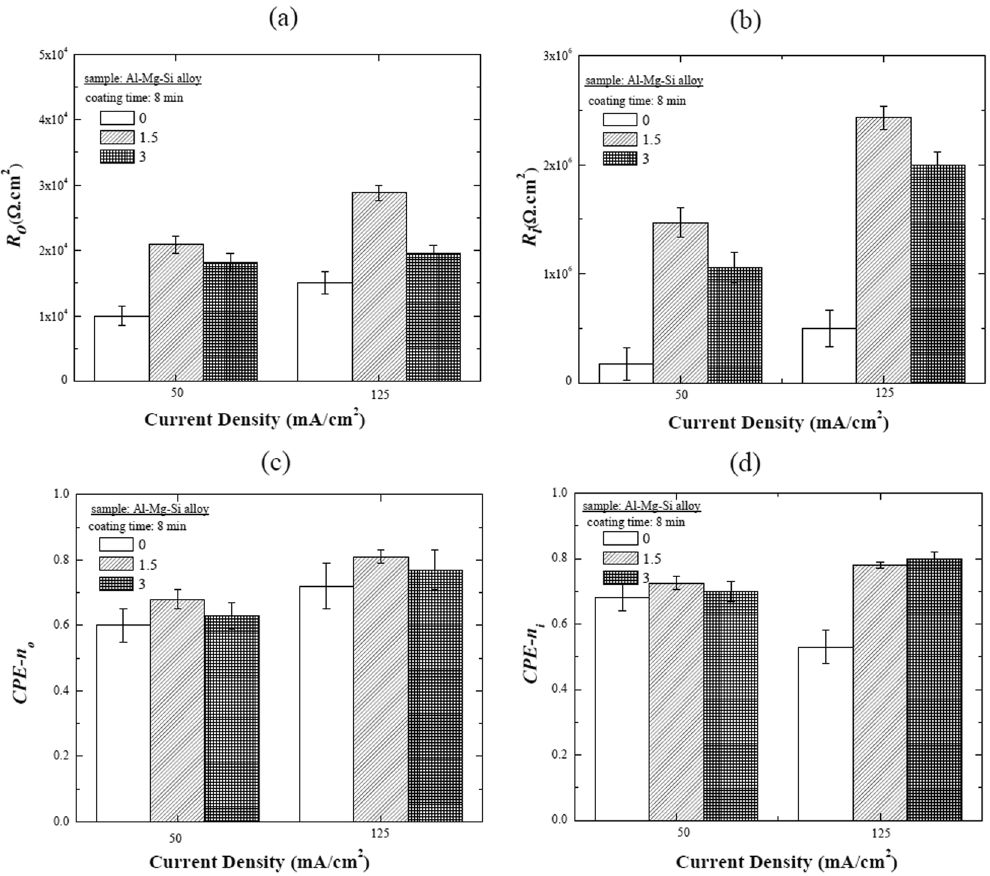
Figure 7. Representation of the EIS-fitted R 0 , R i , n 0 , and n i values of the coatings formed at two different current densities in electrolytes containing different concentrations of Na 3 AlF 6